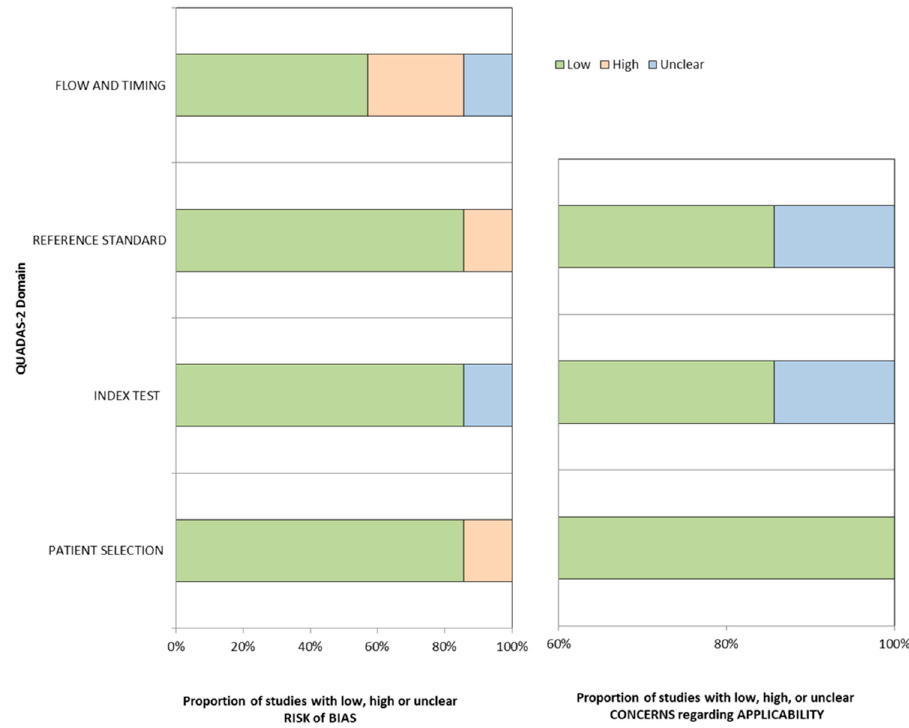
Figure 2. Results of study quality assessments according to Quality Assessment Tool for Diagnostic Accuracy-2 criteria.